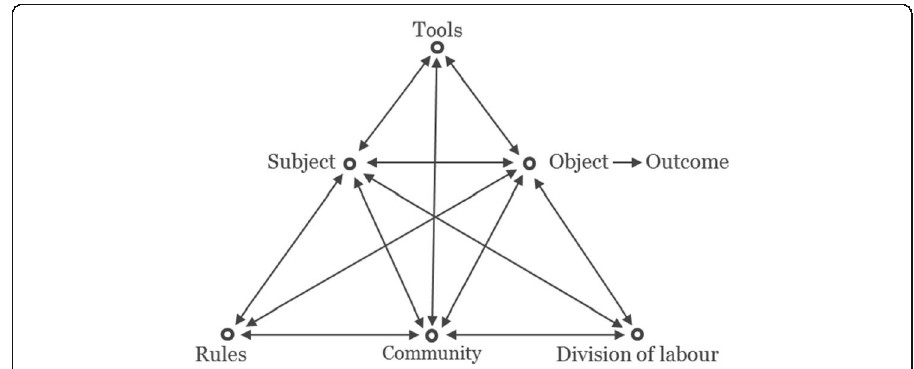
Fig. 1 CHAT Triangle representing an activity system